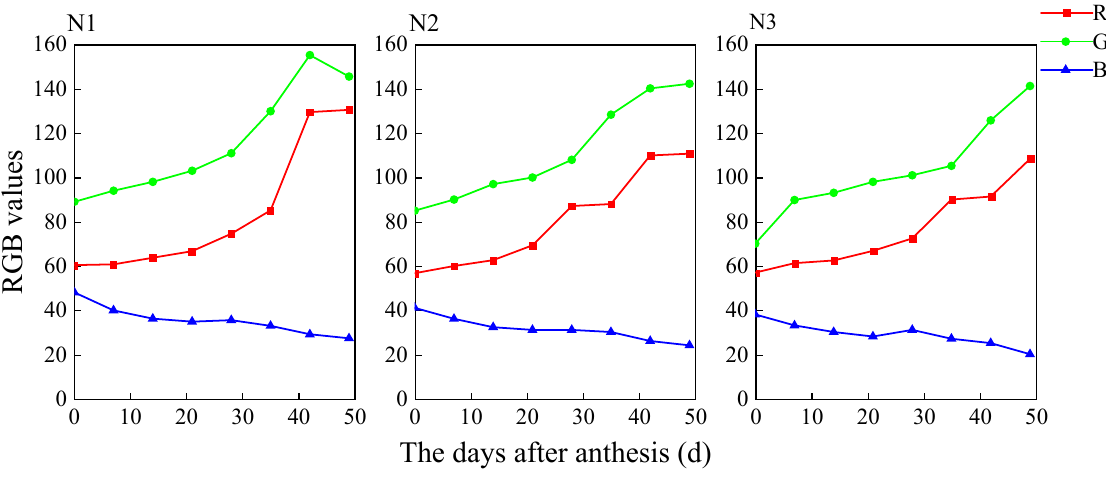
Figure 5. Dynamic changes in leaf RGB values with high, medium, or low nitrogen supplies in YY8 after anthesis. Further analysis of the changing trend was conducted, where x represents the days after the anthesis of the rice represented, and y represents the color values. Linear and non ‐ linear regression model fitting (conic curve, cubic curve, logarithmic curve, S ‐ shaped curve, power function curve, inverse function curve, logistic curve, and exponential equa ‐ tion function) were employed to analyze the relationships between the days after anthesis of rice and the RGB value parameters. The determination coefficient (R 2 ) of the simulation degree of each model was compared and analyzed, and the one with an R 2 closest to one was selected to construct the fitting model. R and G values were fitted using the logarith ‐ mic equation y = ae bx , and the B value was fitted employing the linear equation y = a + bx. Following the fitting, the equation was obtained, as provided in Table 5. The determina ‐ tion coefficient (R 2 ) of the simulation degree of each model was significantly correlated, indicating that the fitting effect of the model was highly consistent. Regardless of rice variety, parameter a in the fitting equations of both R and G values decreased as the nitrogen supply level increased. However, the absolute value of param ‐ eter b represented the slope. The steeper the slope, the faster the R and G values increased. The increase in parameter b in HD5 elevated at first but declined as the nitrogen supply levels increased, whereas parameter a in both YJ4227 and YY8 decreased and remained unchanged only in CY5. The parameter a in the fitting equation of the B value agrees with the above ‐ mentioned value changes of R and G. The absolute value of parameter b repre ‐ sents the slope. The greater the slope, the faster the leaf G values dropped. Among them, the R and G values of HD5, YJ4227, and YY8 coincided with the previously mentioned R and G values, whereas those of CY5 decreased as the nitrogen supply level increased. The findings reveal that curve ‐ fitting can depict the changing rate of the leaf RGB values in rice after anthesis. However, only the first ‐ level data of RGB value could not describe the detailed color changes in the rice leaf of different varieties after anthesis. It was therefore necessary to further analyze the RGB values and introduce derivative parameters in the calculation formula.